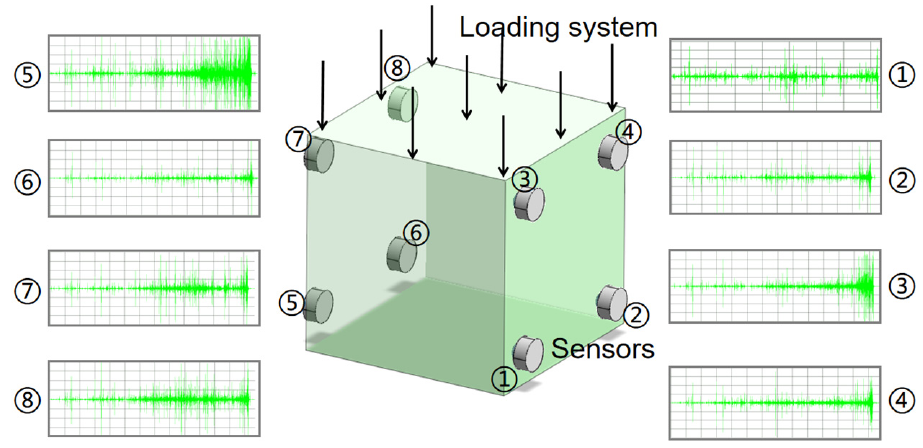
Figure 3. AE sensor arrangement. (The serial number s ① - ⑧ a re for the eight channels of the mon- itor).